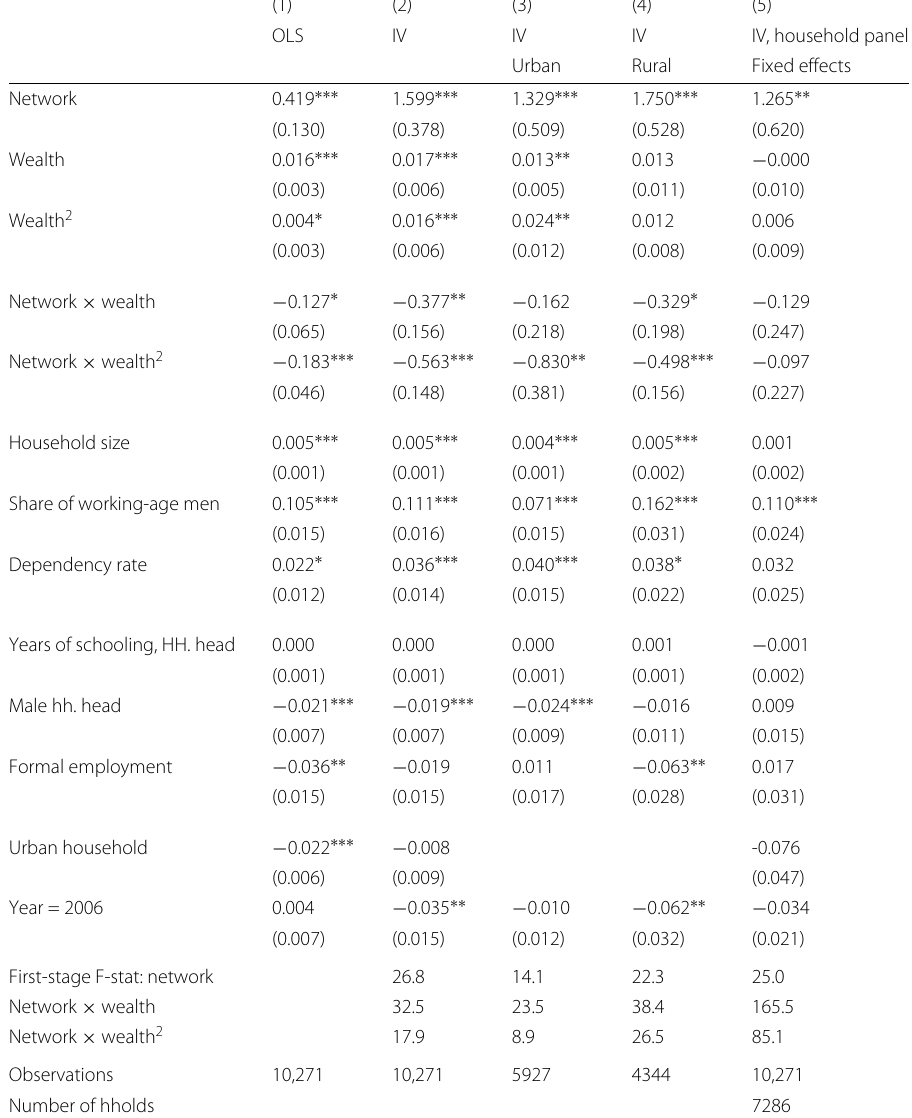
Table 5 Household determinants: with wealth polynomial (1) (2) Urban Rural Fixed